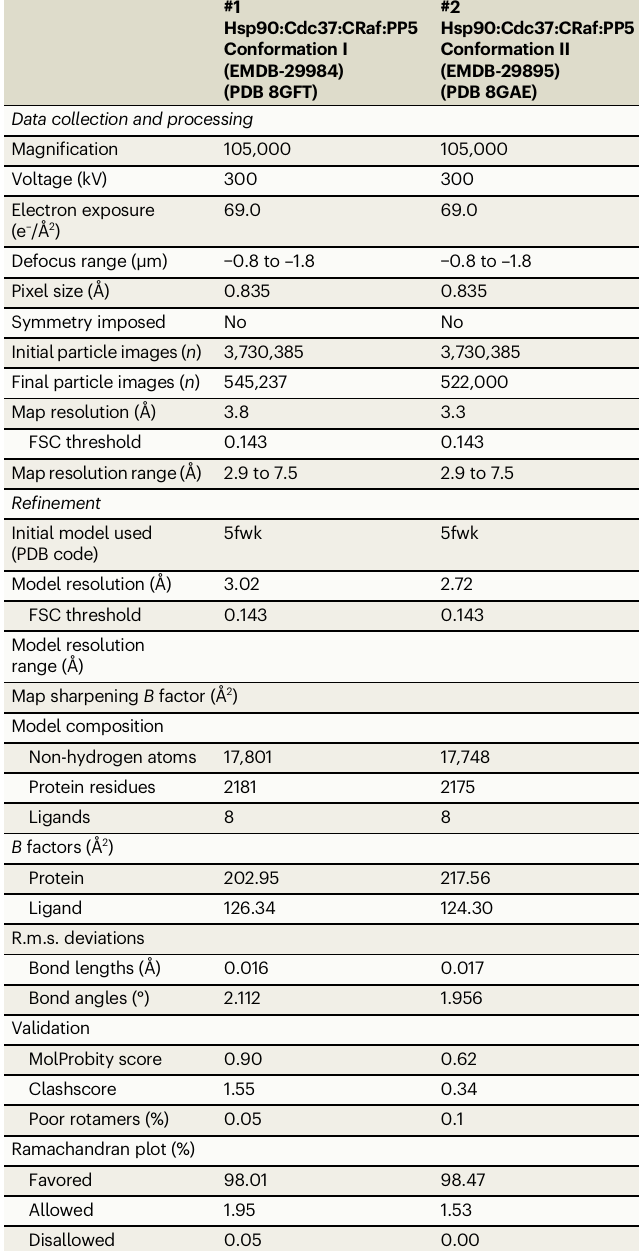
Table 1 | Cryo-EM data collection, re fi nement and validation